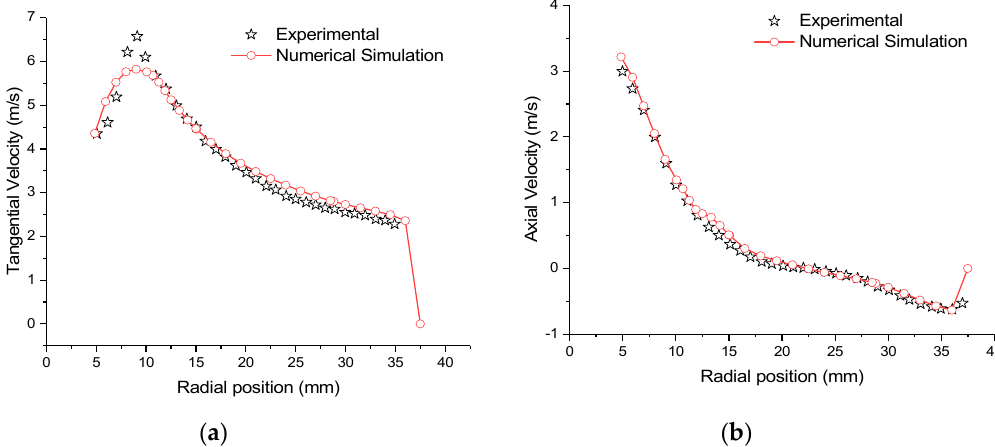
Figure 1. Comparison of distribution of tangential velocity ( a ) and axial velocity ( b ).